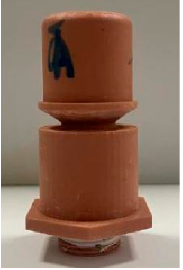
Figure 2. Experiment prototype.